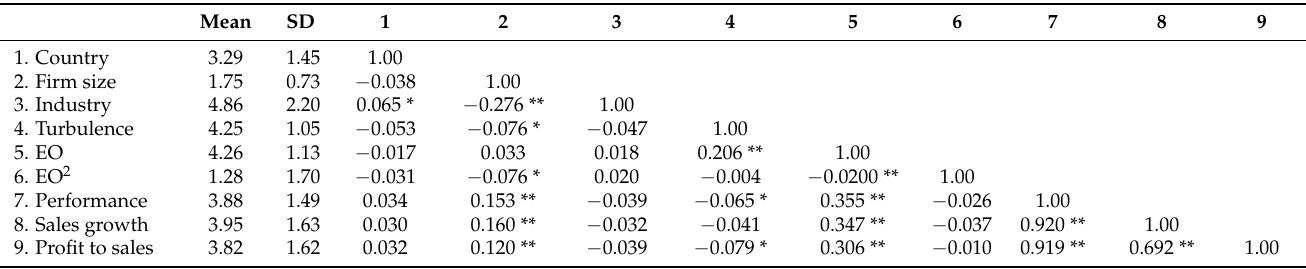
Table 1. Means, SDs, and correlations (n =